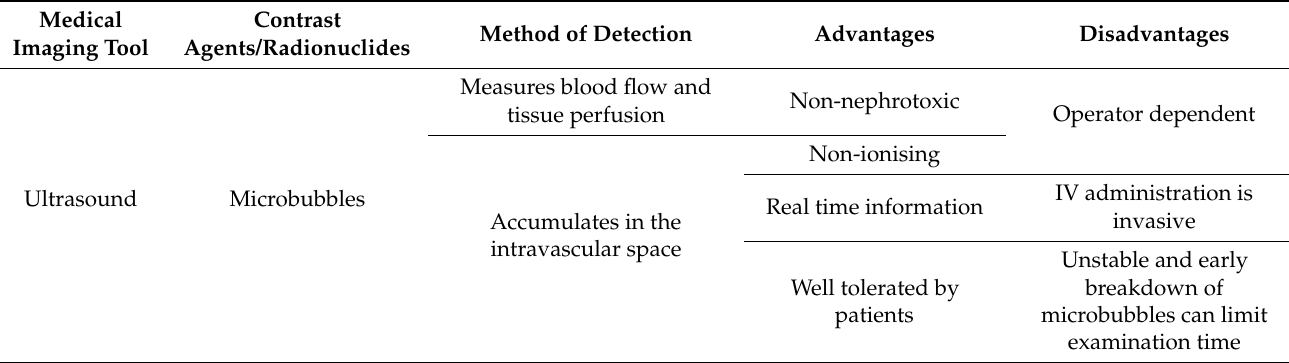
Table 1. The different methods of tumour detection by current medical imaging modalities and their contrast agents or radionuclides—advantages and disadvantages. Adapted from [65,67,72,74,77–84].